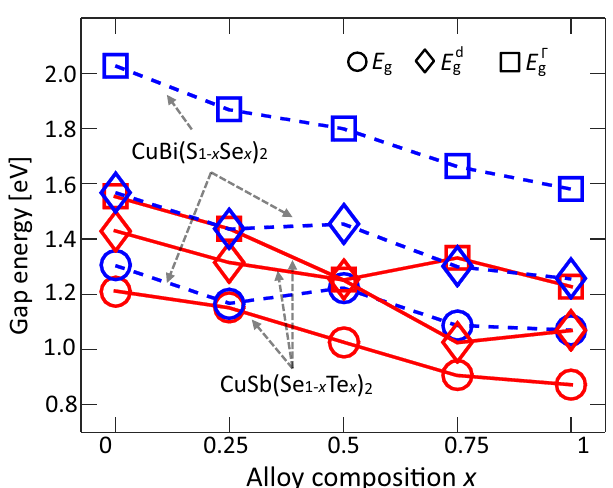
Fig. 2. Energies of the fundamental gap (circles), the di- rect gap (rhomboids), and the direct Γ-point gap (squares) for the CuSb(Se,Te) 2 alloy (red marks) and the CuBi(S,Se) 2 alloy (blue